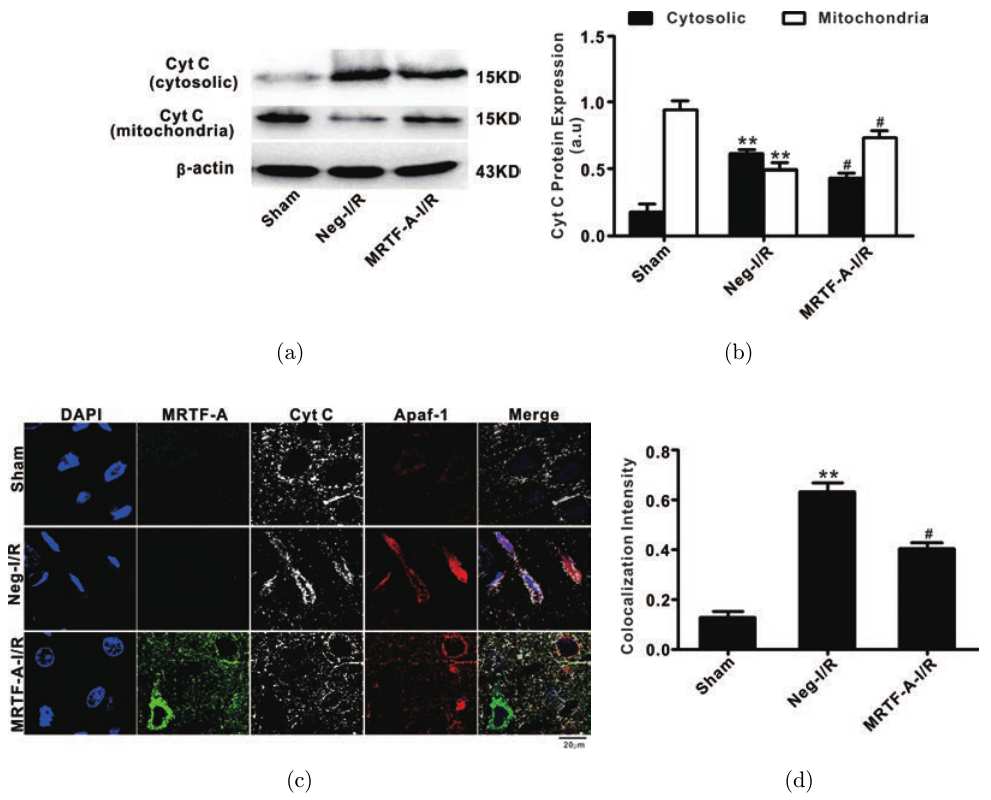
Fig. 4. E®ect of MRTF-A overexpression on cytochrome C (Cyt C) mitochondrial apoptotic pathway in rats cerebral I/R injury. (a) The release of Cyt C in cytosolic and mitochondrial was analyzed by western blot analysis. (b) Quantitative analysis of the release of Cyt C. (c) The colocalization of Cyt C and apoptotic protease activating factor-1 (Apaf-1) in the cytoplasm was analyzed by immuno°uorescence assay. (d) Quantitative analysis of Cyt C and Apaf-1 colocalization °uorescence intensity. * P < 0 : 05, ** P < 0 : 01 versus the sham group, # P < 0 : 05 versus the Neg-I/R group. Data were presented as mean (cid:1) SD, n ¼